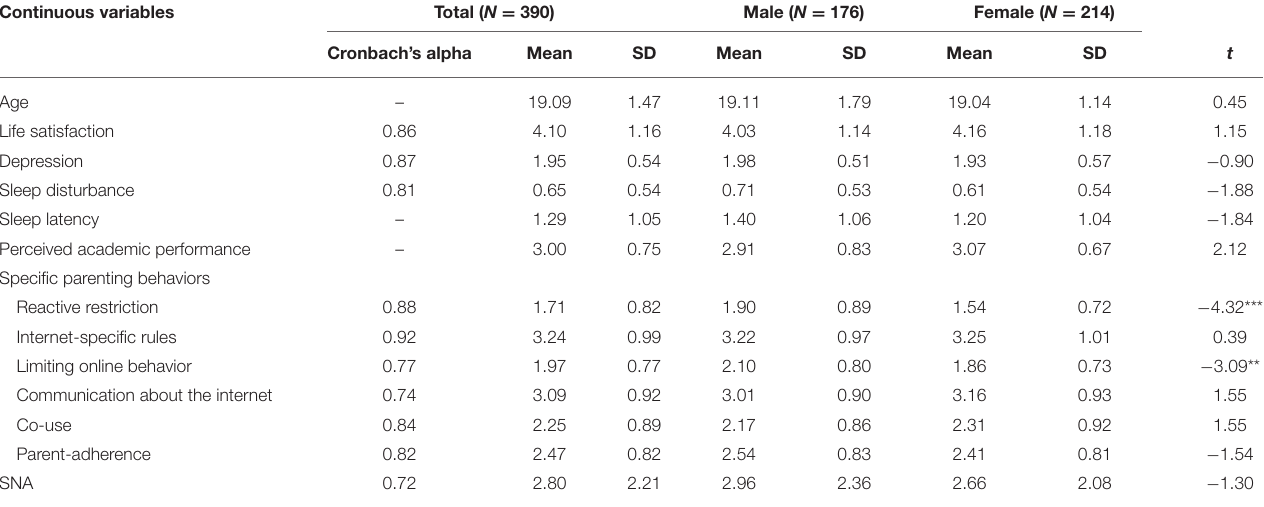
TABLE 1 | Descriptive statistics of the key